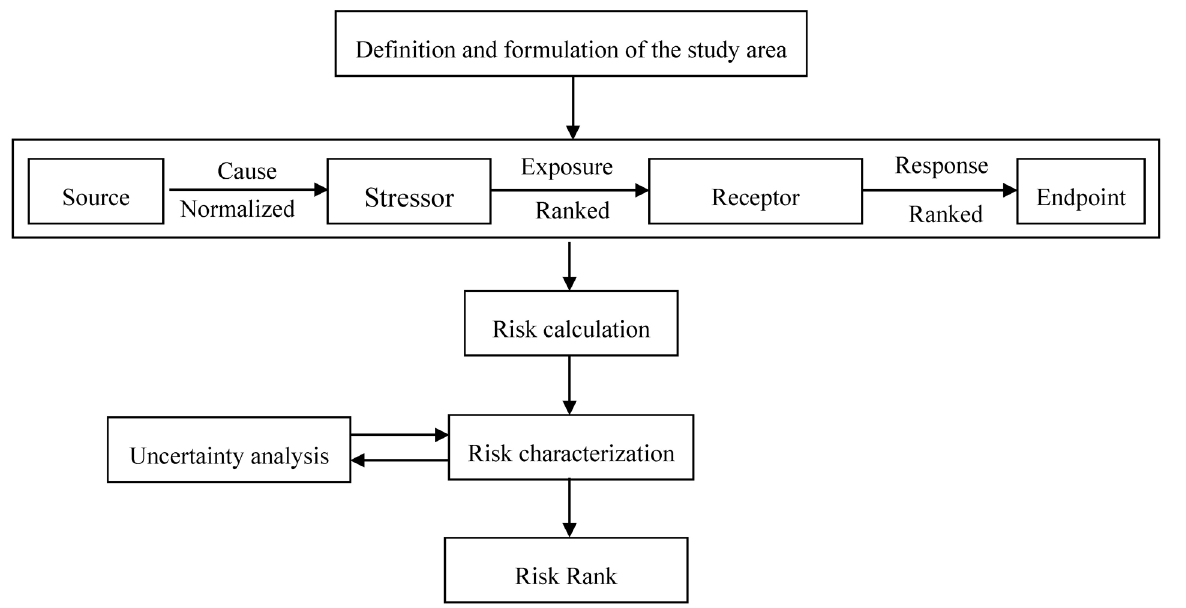
Fig 2. Regional groundwater environment risk assessment procedure.